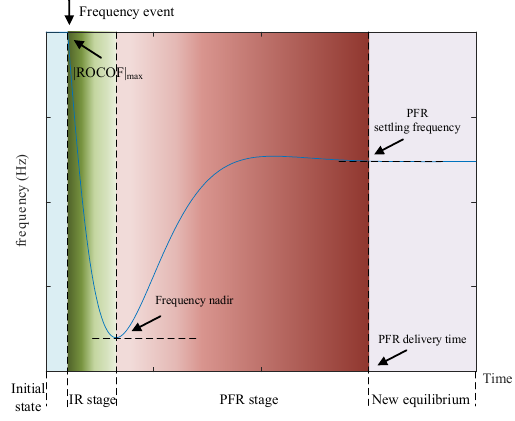
Figure 2. Multiple temporal stages of frequency response.